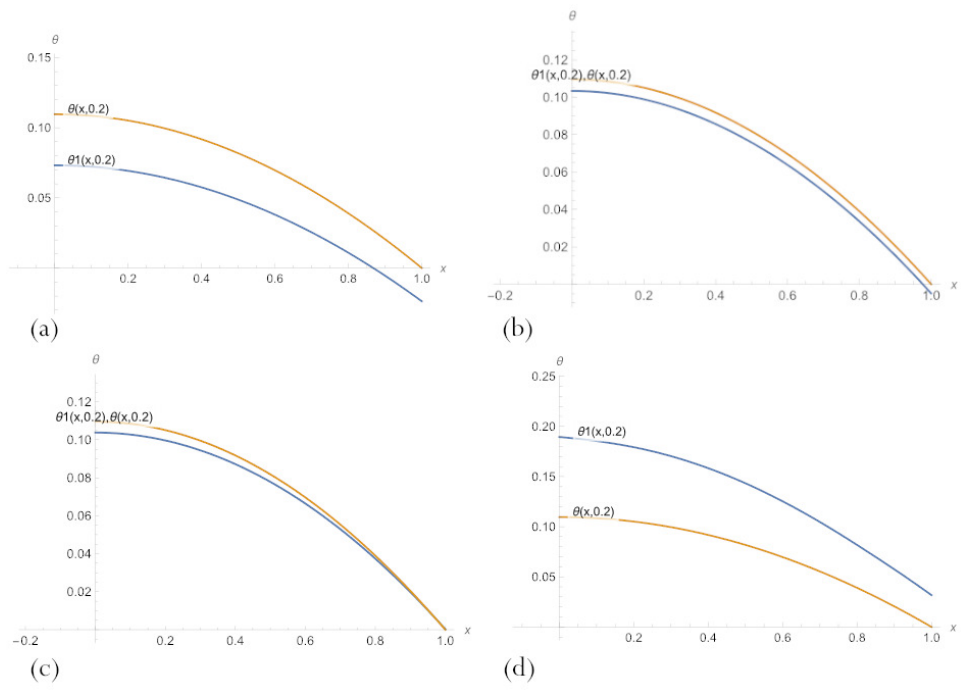
Figure 7. A comparison of PBA-PINN (20) for ( a ) n = 3 and ( b ) n = 10, ( c ) PBA-PINN (23) for n = 3, N = 1, and ( d ) classical PINN with n = 20 neurons of a hidden layer and activation function (18), after learning by minimising the loss (21) and an exact solution to the problem (11), for δ =